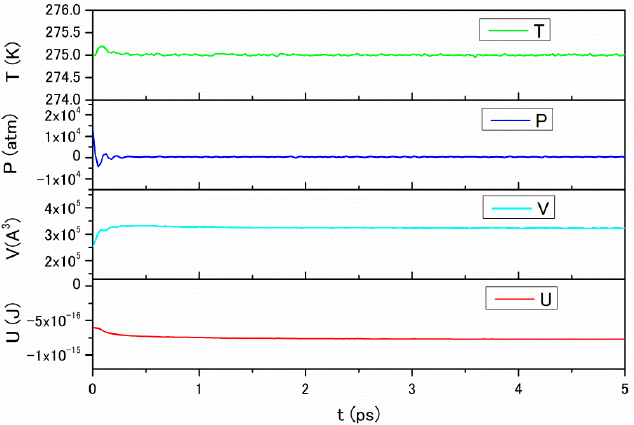
Figure 1. The monitor parameters of the system during 50,000 steps under 30 MP at 275 K. T: temperature, P: pressure, V: volume, U: internal energy.